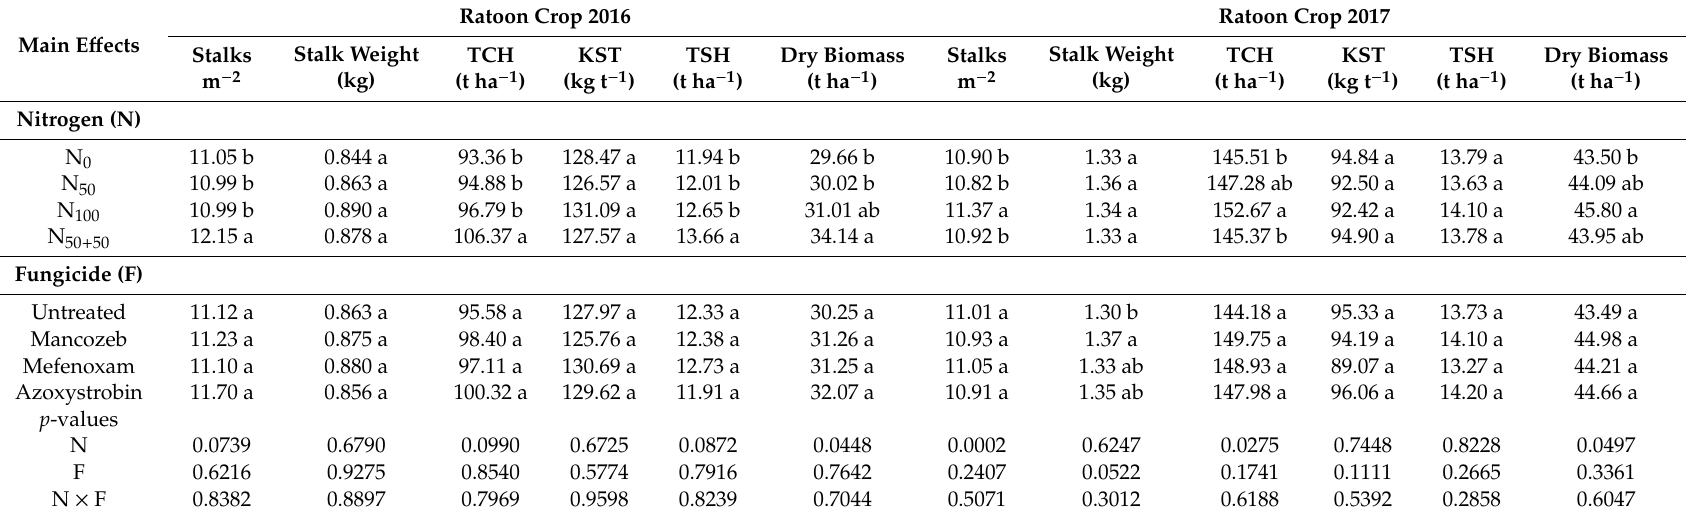
Table 9. Least Square means of sugarcane yield attributes and yields in nitrogen and fungicide treatments in 2016 and 2017 ratoon crops.